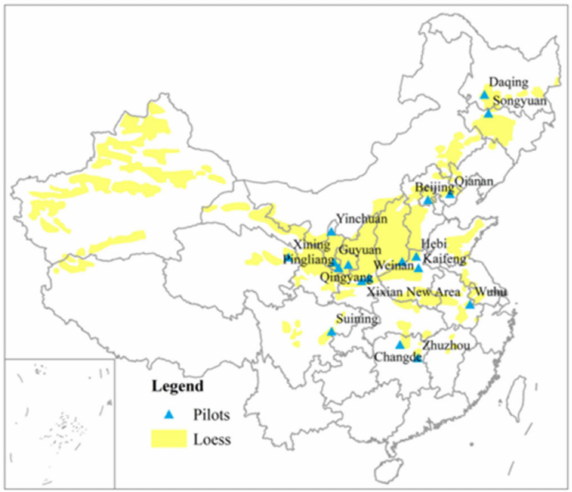
Figure 1. The pilot sponge cities in the loess